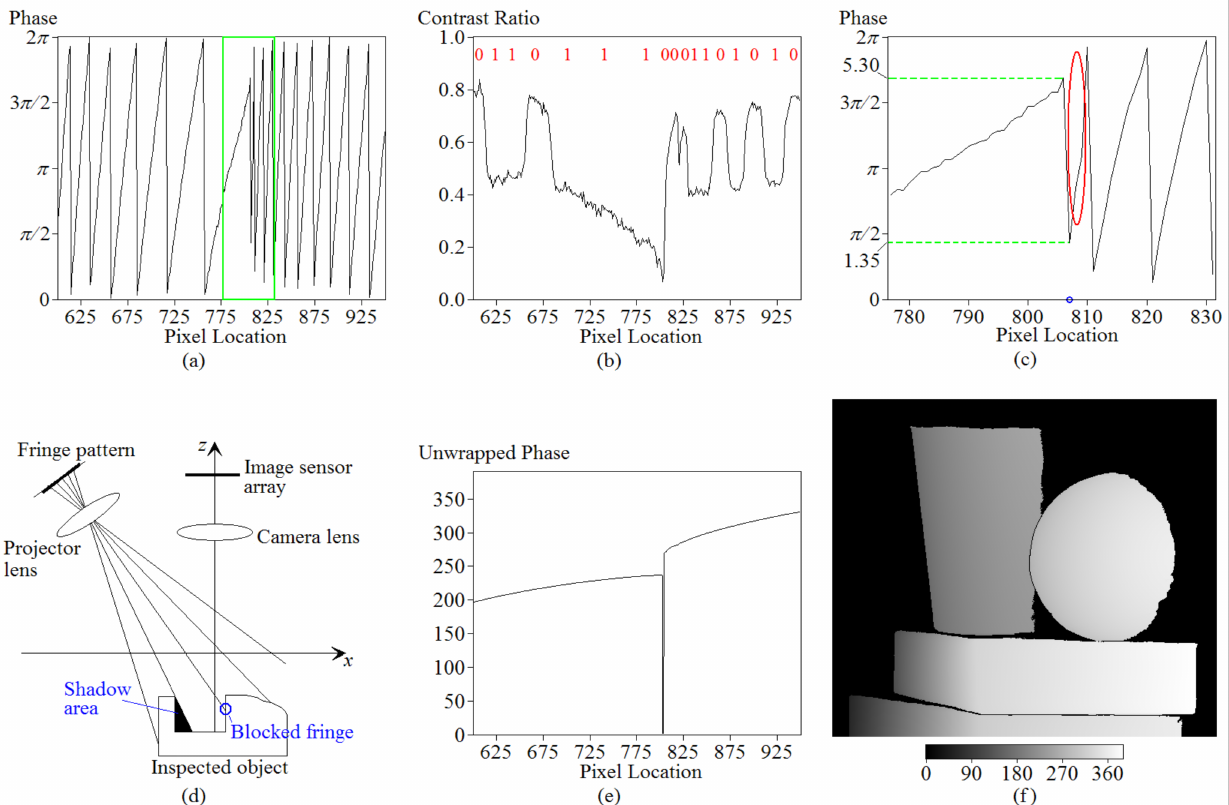
Figure 17. ( a ) The phase distribution along the image row that is marked with a green frame in Figure 16b. ( b ) The corresponding contrast distribution. ( c ) A close-up view of the green frame that is marked in ( a ). ( d ) A configuration illustrating obstructions and shadows caused by tilted projections. ( e ) The unwrapped phase distribution along the sampled image row. ( f ) The entire unwrapped phase